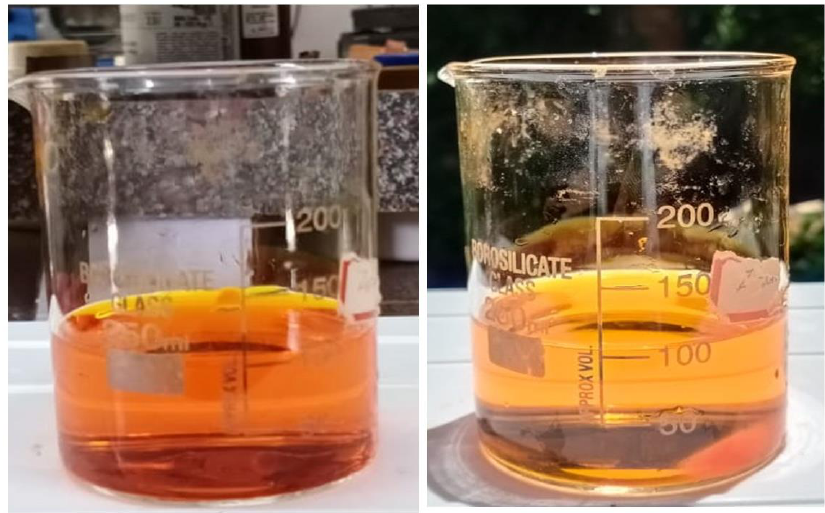
Figure 10. The color intensity before and after photodegradation using green synthesized ZnO na- noparticles.